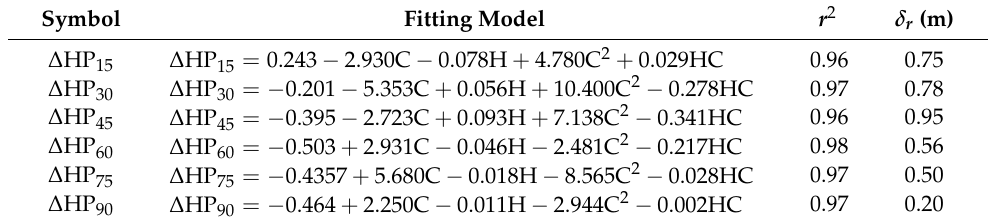
Table 3. The detailed regression results of the fitting models, the CODs and the RMSEs for the